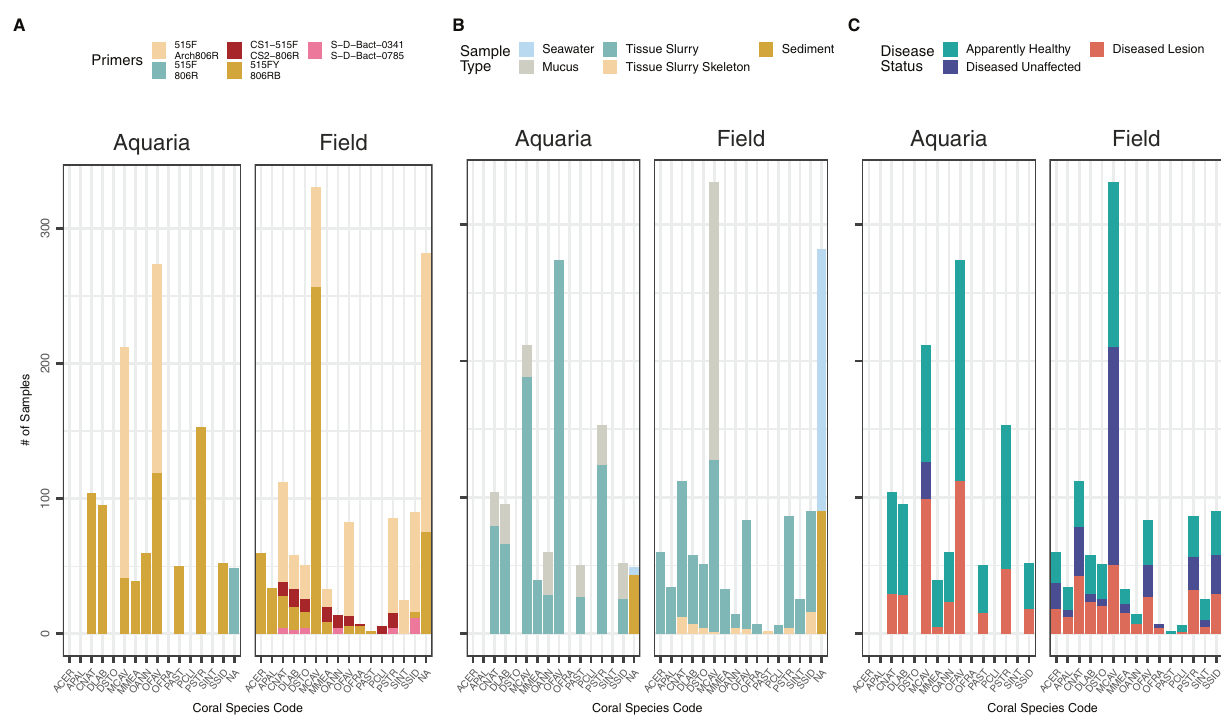
Fig. 1 The number of aquaria and fi eld samples for each coral species. A small subunit (SSU) rRNA gene primer sets, B sample type, and C disease state. NAs in ( A , B ) represent sediment and seawater samples. Coral species codes represent the following: Acropora cervicornis (ACER), Acropora palmata (APAL), Colpophyllia natans (CNAT), Diploria labyrinthiformis (DLAB), Dichocoenia stokesii (DSTO), Montastraea cavernosa (MCAV), Meandrina meandrites (MMEA), Orbicella annularis (OANN), Orbicella faveolata (OFAV), Orbicella franksi (OFRA), Porites astreoides (PAST), Pseudodiploria clivosa (PCLI), Pseudodiploria strigosa (PSTR), Stephanocoenia intersepta (SINT), and Siderastrea siderea